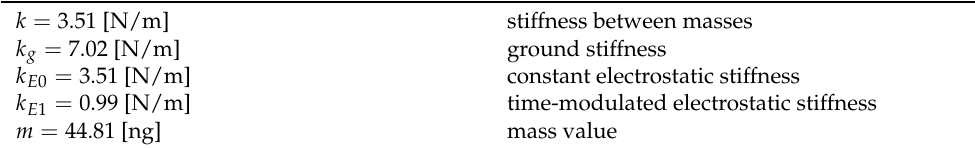
Table 3. Spring-mass chain lumped